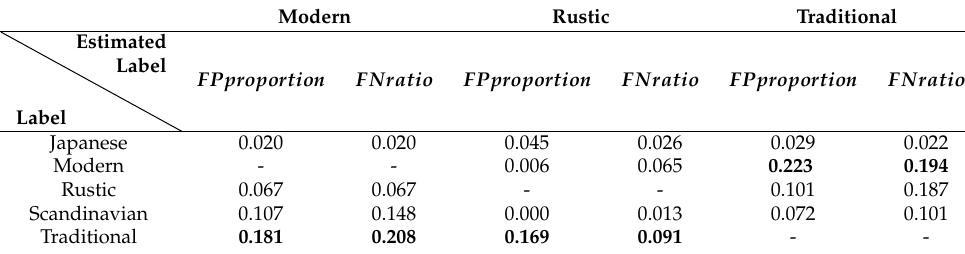
Table 6. FPproportion and FNratio for the proposed model.